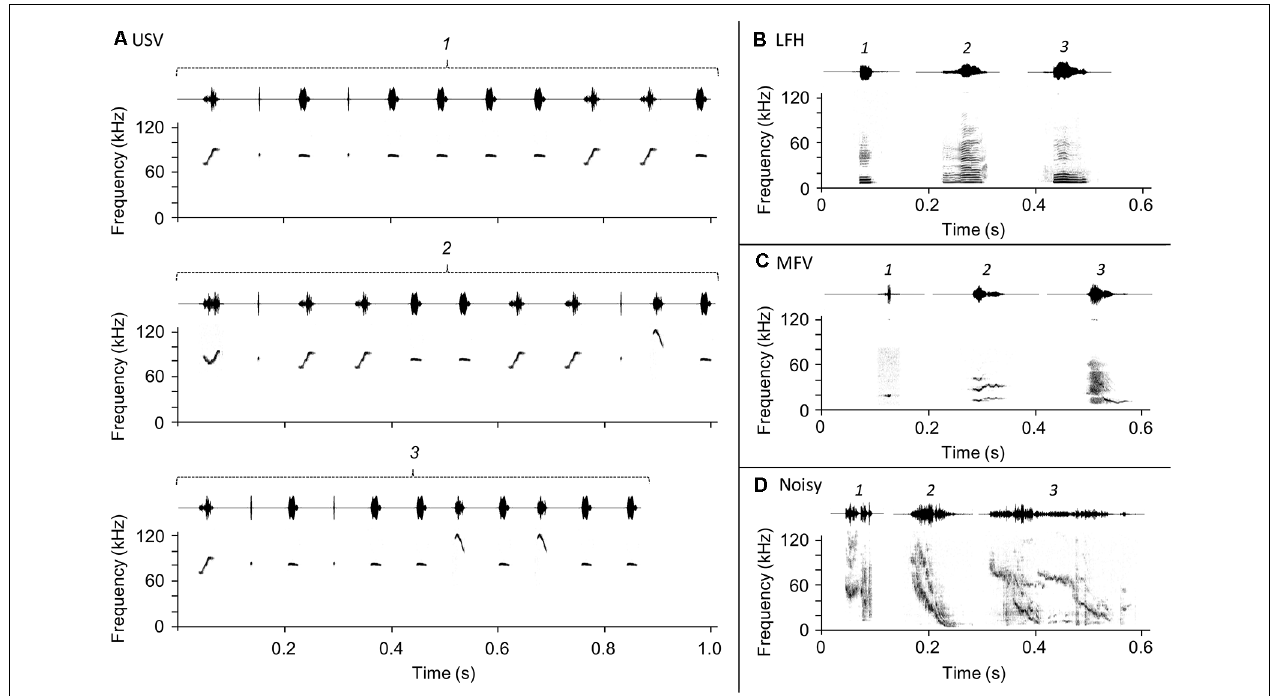
FIGURE 1 | Vocalization stimuli used in the playback experiment. Three exemplars (labeled 1 , 2 , and 3 ) of each vocalization category were presented in pseudorandom sequences throughout the playback period. (A) Ultrasonic vocalizations (USVs), (B) low-frequency harmonic call (LFH), (C) mid-frequency vocalization (MFV), (D) Noisy